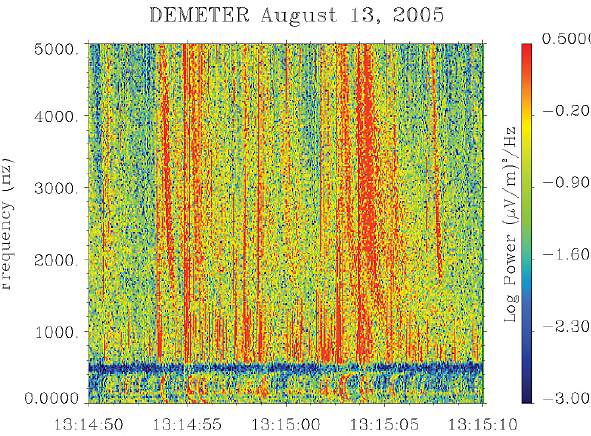
Fig. 1c. Detailed frequency–time spectrogram of the electric com- ponent of the waves in the 0–5000Hz range measured onboard Demeter from 13:14:50 and 13:15:10UT on August 13 2005, when Demeter is in burst mode (see Fig. 1b). Whistlers with frequency– time dispersion can be clearly distinguished. Their dispersion is however small, which comes from the fact that lightnings occur be- low the spacecraft, in the same hemisphere. Below the local proton gyro frequency (500Hz), a number of proton whistlers, also related to lightnings, are visible. Using the WWLLN lightnings database, it was verified that Demeter encountered a number of lightnings over a very large region of thunderstorms during this northern pass over Asia.